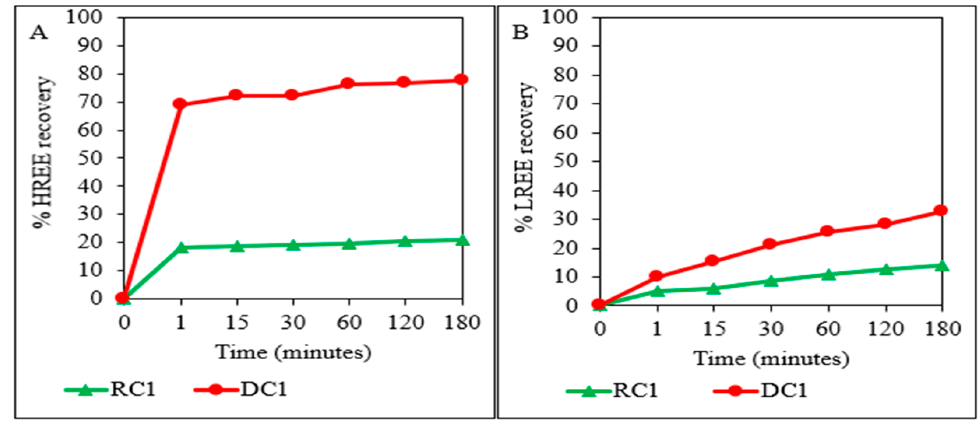
Figure 6. RC1 and DC1 % HREEs ( A ) and % LREEs ( B ) leaching recovery under the optimised leaching parameters (HCl concentration of 2 M, solid:liquid ratio of 10 g/L, leaching temperature of 50 °C, D 90 = − 106 μ m, stirrer speed 550 rpm).